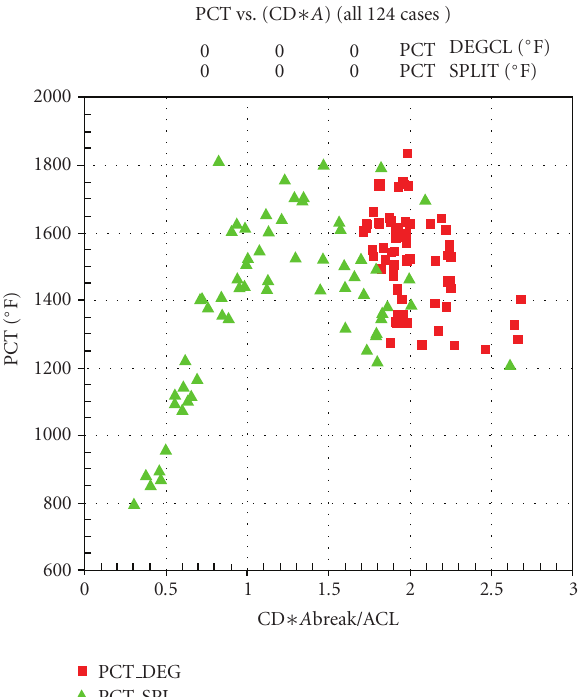
Figure 8: Oxidation and PCT from the ASTRUM 124 run set.